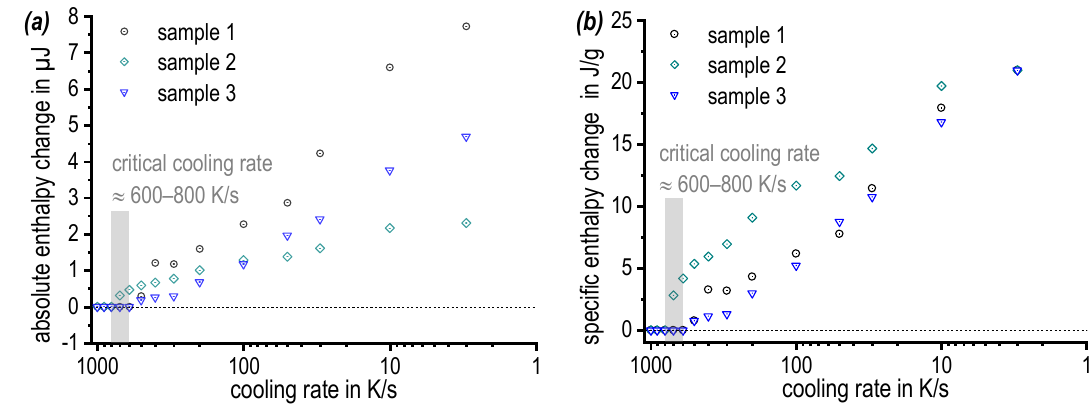
Figure 7. Differential fast scanning calorimetry (DFSC) results of three samples 7068: ( a ) absolute enthalpy change and ( b ) specific enthalpy change.